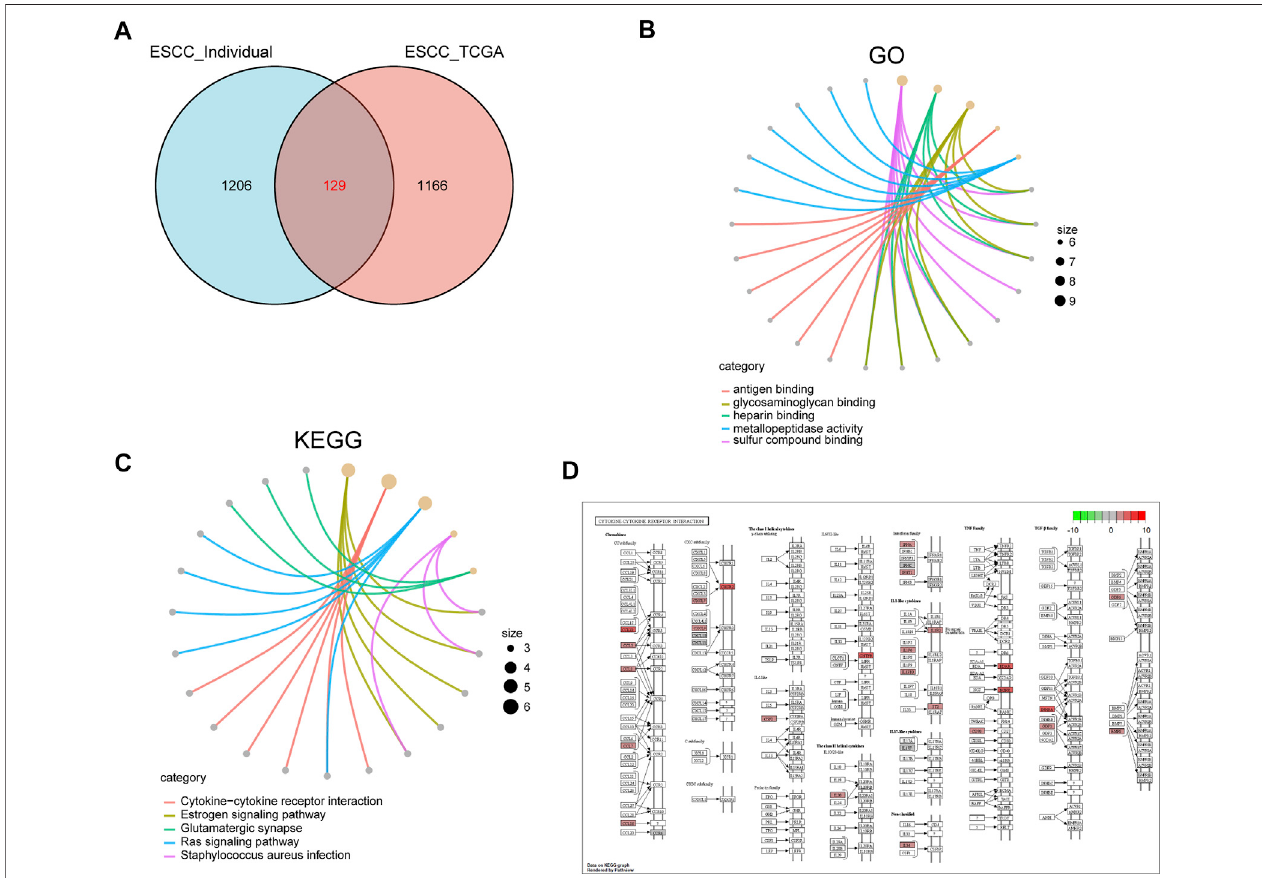
FIGURE6| GOandKEGGanalysisofdifferentiallyexpressedgenesinhighandlowSPOCD1expressiongroups. (A) Thedifferentiallyexpressedgenesofhighand low SPOCD1expression groupin thesequencingdataofourcenter and TCGA data set wereintersected; (B) GObiological function enrichment analysis,the sizeofthe dot represents the proportion of gene enrichment in this function; (C) KEGG pathway enrichment analysis, the annotation is the same as before; (D) Cytokine-cytokine receptor interaction, the pathway of signi fi cant enrichment ofKEGG; the red representsthe degree of gene enrichment, the redder the color, the more obvious the upregulation of the gene in the pathway; the greener the color, the more obvious the downregulation of the gene in the pathway. GO, Gene Ontology; KEGG, Kyoto Encyclopedia of Genes and Genomes; SPOCD1, SPOC Domain Containing 1; TCGA, The Cancer Genome Atlas.